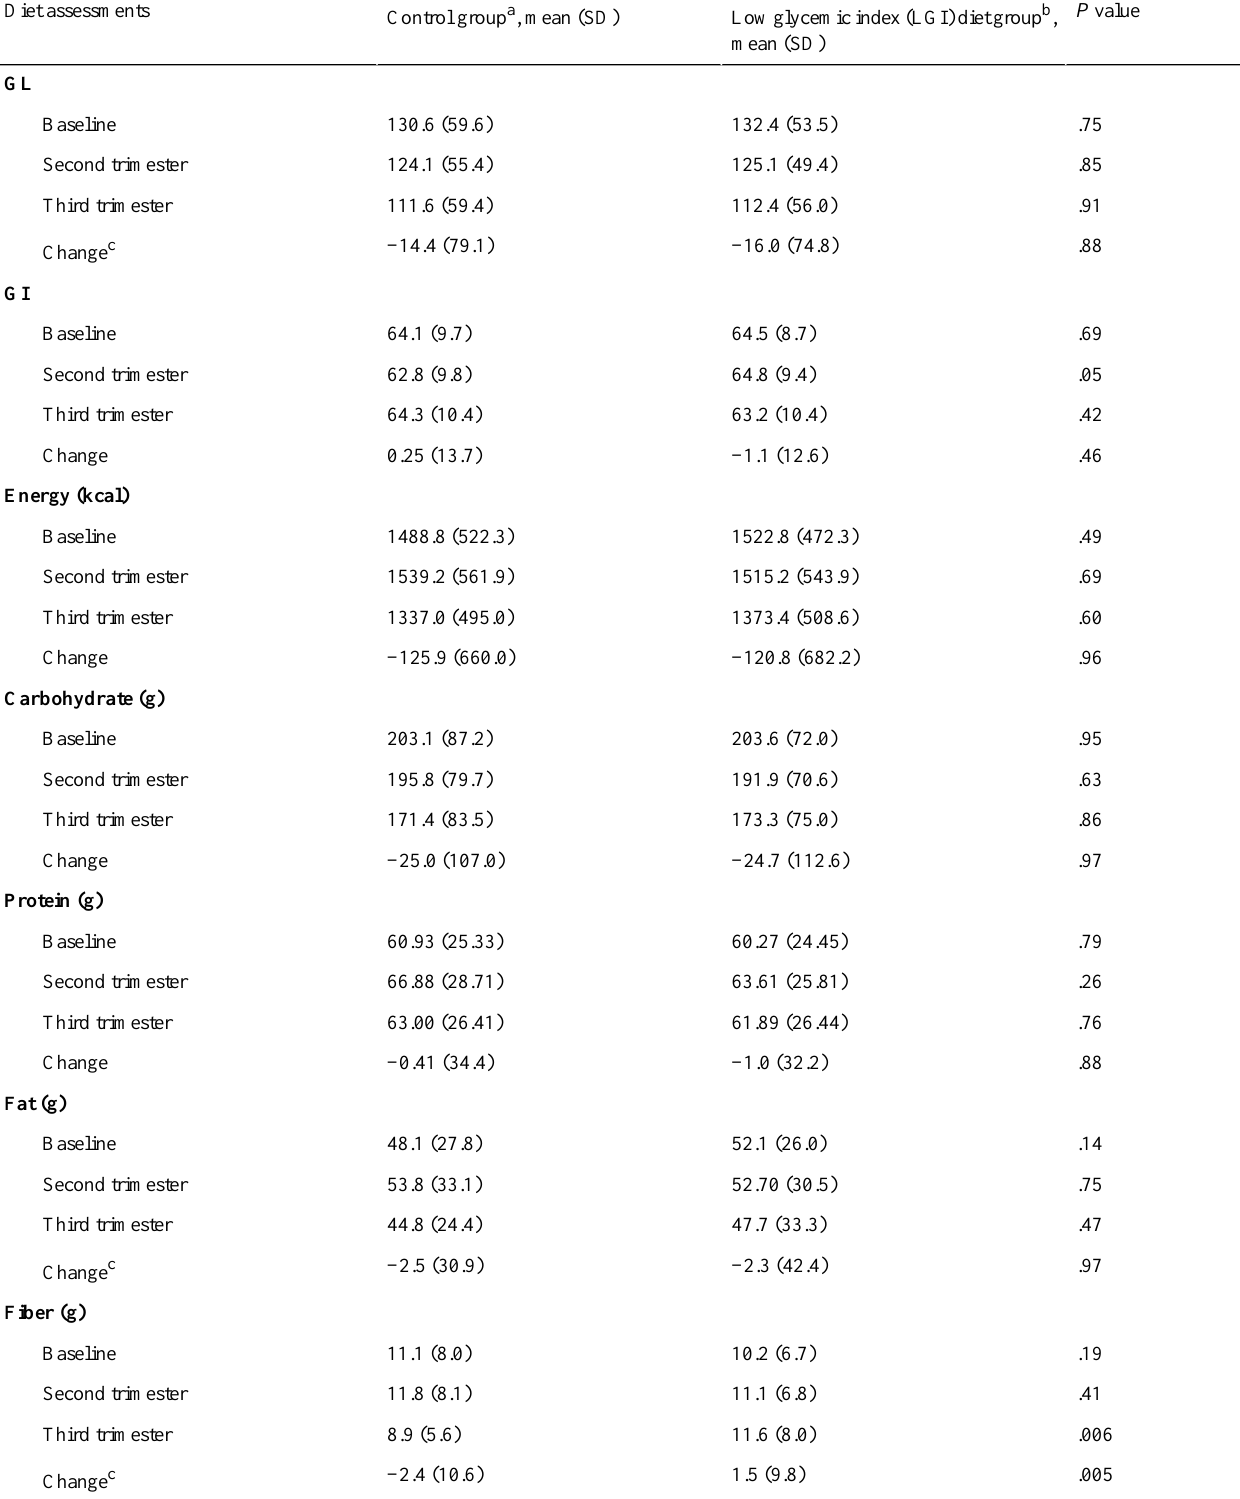
Table 3. Dietary intake of glycemic load (GL), glycemic index (GI), and nutrients (per day) at 3 visits and changes.